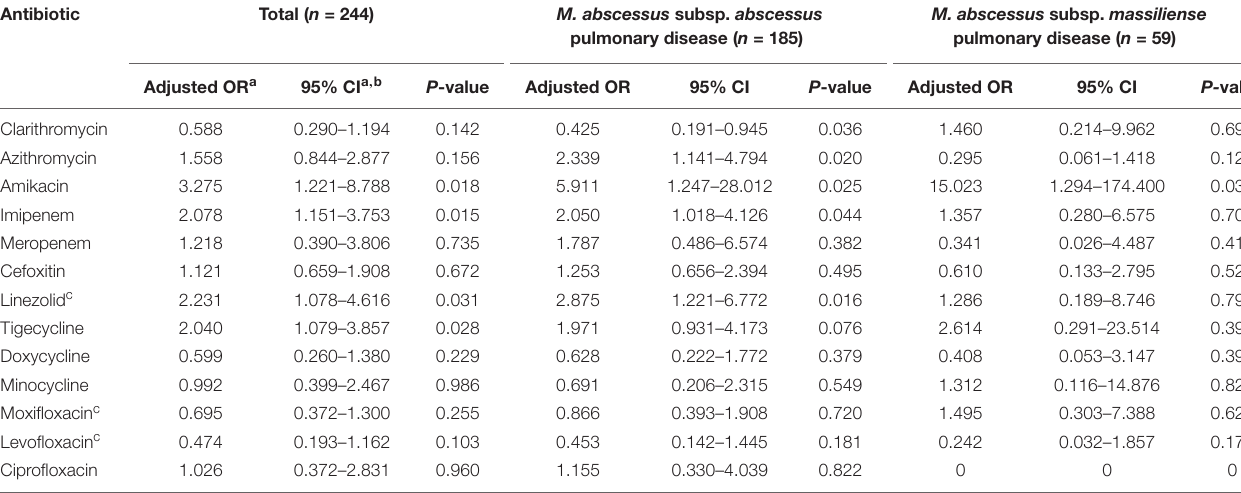
TABLE 3 | Treatment success with individual antibiotics. Antibiotic Total ( n = 244) M. abscessus subsp. abscessus